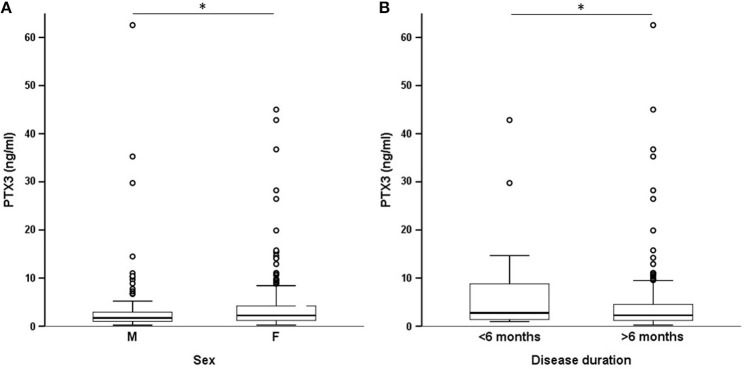
PTX3 levels and demographics. These panels show the existing differences in systemic expression of PTX3 by selected demographics. PTX3 levels were higher in females (A) and in patients with early-onset disease (B). *p < 0.05.